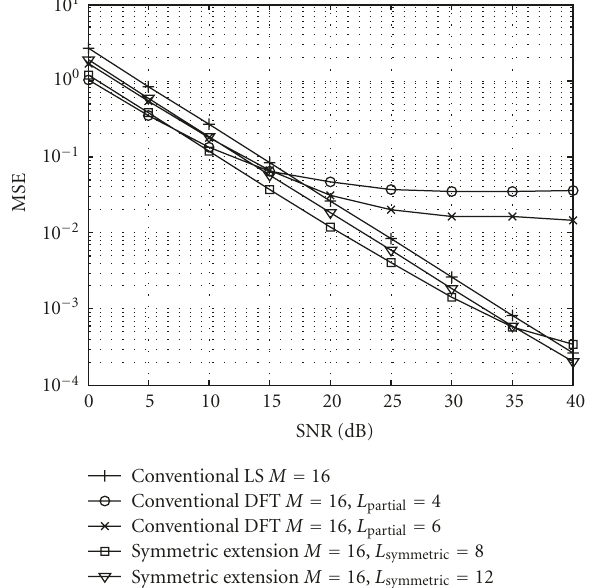
Figure 8: Comparing MSE performance with proposed estimator, conventional DFT estimator, and LS estimator, when M = 16, L partial = 4 . 6, and L symmetric = 8 . 12.